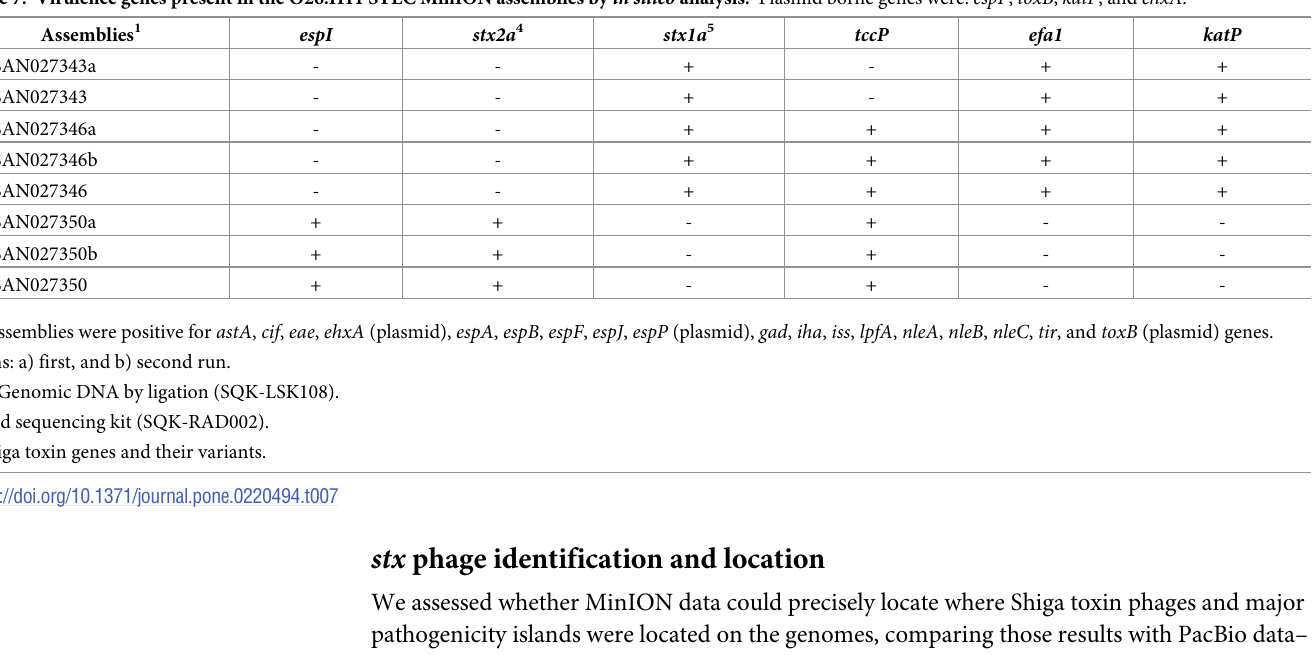
Table 7. Virulence genes present in the O26:H11 STEC MinION assemblies by in silico analysis. Plasmid borne genes were: espP , toxB , katP , and ehxA . Assemblies 1